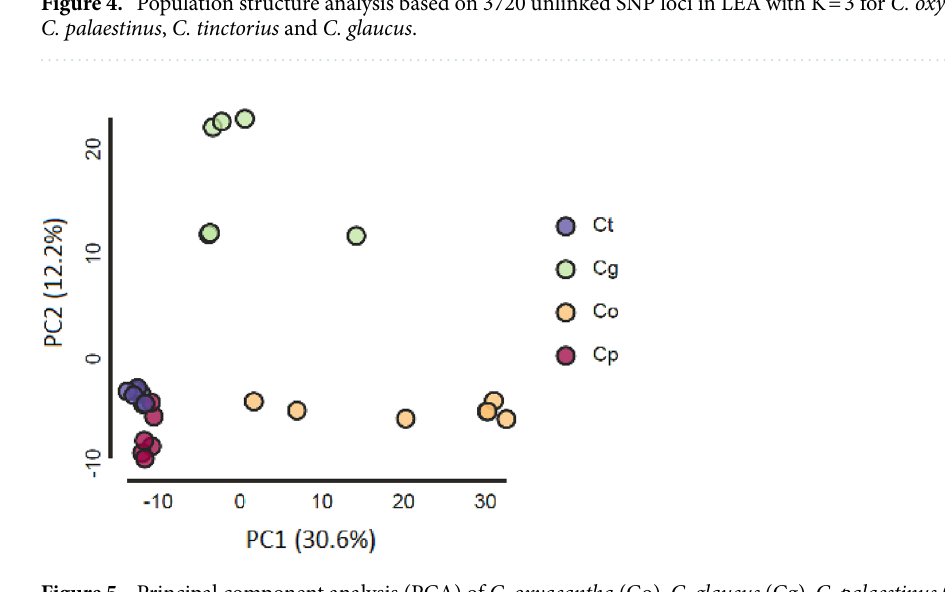
Figure 5. Principal component analysis (PCA) of C. oxyacantha (Co), C. glaucus (Cg), C. palaestinus (Cp) and C. tinctorius (Ct) along the first and second